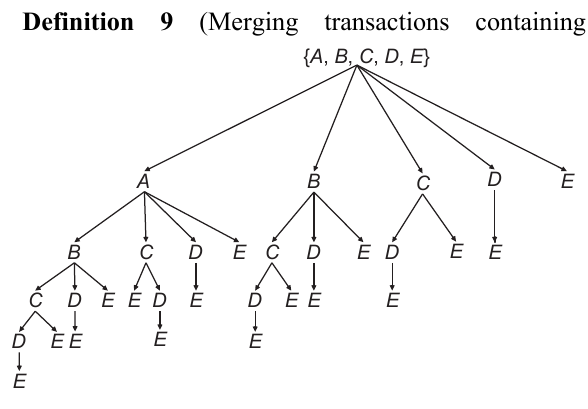
Fig. 3 An example search